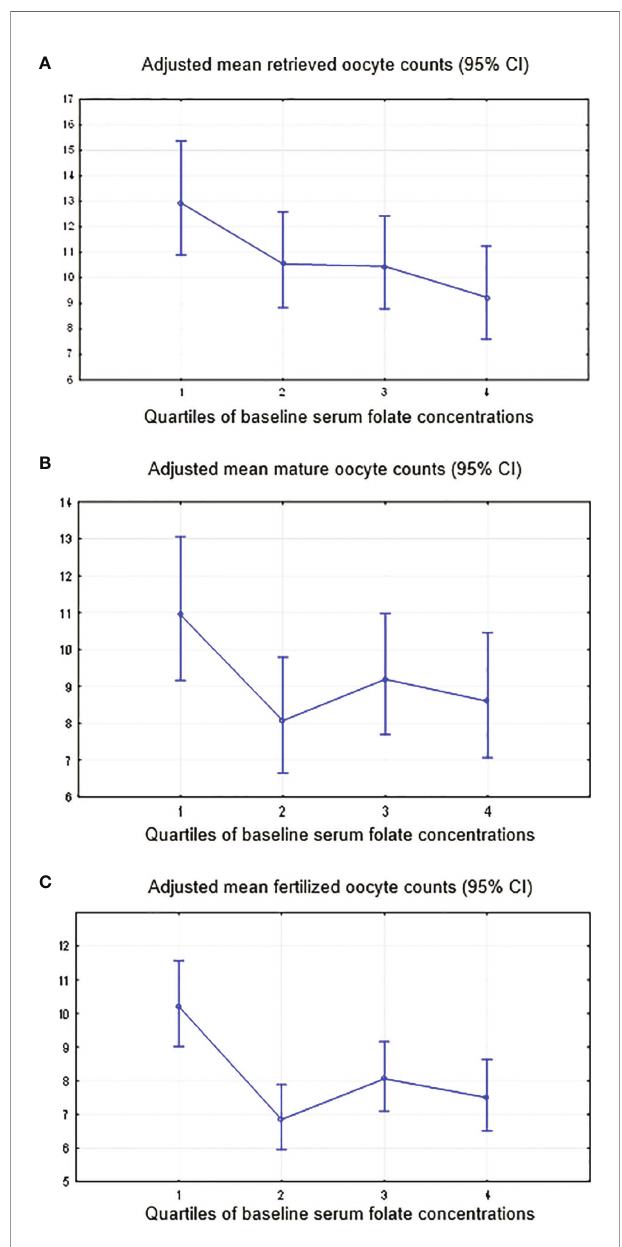
FIGURE 4 | Adjusted mean oocyte counts by the quartiles of the serum folate level. (A) Total oocytes yield, adjustment for IVF/ICSI attempts (0; 1) and continuous BMI, baseline serum AMH and APTT, duration of stimulation and dose of FSH. (B) Mature oocytes, adjustment for continuous BMI, baseline serum AMH and APTT, duration of stimulation and dose of FSH. (C) Fertilized oocytes, adjustment for continuous BMI, baseline serum AMH and APTT, duration of stimulation and dose of 4.07 (95% CI: 0.83, 19.9) for live birth ( Figure 6C ), with the same adjustments as for serum folate, compared with women in the lowest quartile (<4.55) ( Table 4 ). Women in the 3 rd quartile of the Ca/Mg ratio (4.78-5.01) had a signi fi cant OR of 7.09 (95% CI: 1.45, 34.6) for biochemical pregnancy and a tendency of a higher OR for clinical pregnancy (3.14 (95% CI: 0.66, 14.9)) and life